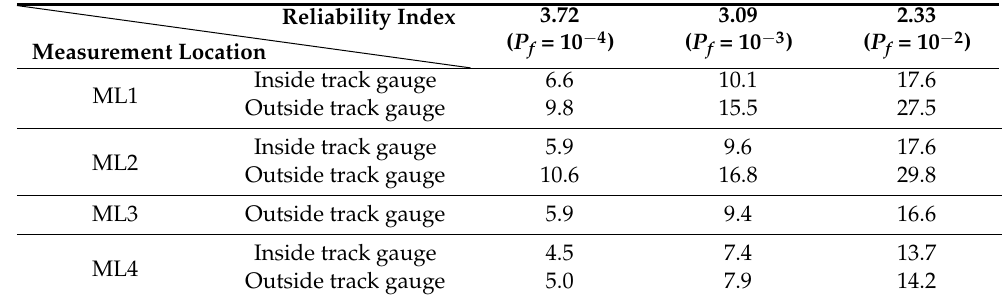
Figure 7. The variations in the reliability indexes with the number of years in service: ( a ) ML1 and ML2; ( b ) ML3 and ML4. Table 4. The number of years in service corresponding to the reliability index for the four MLs (unit: years).